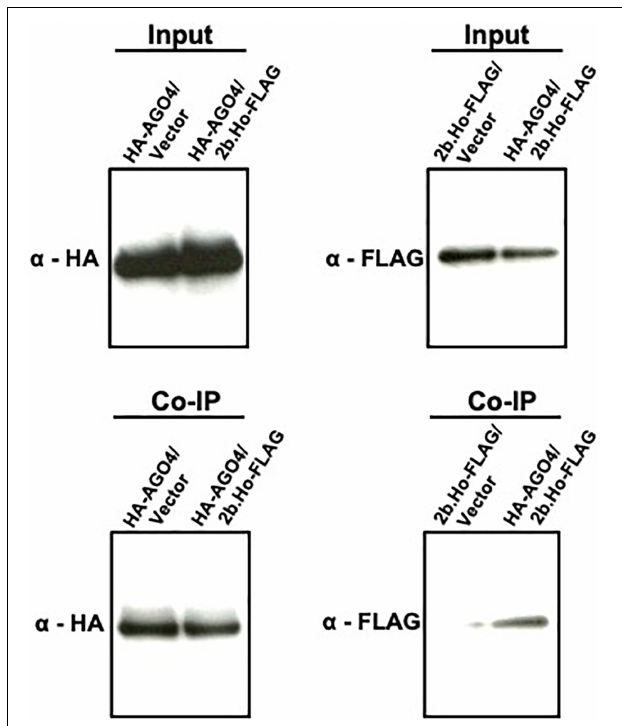
FIGURE 11 | Co-immunoprecipitation (Co-IP) analysis of AGO4 protein with 2b protein of CMV(Ho) employing the transient expression agroinfiltration method in N. benthamiana . Hemagglutinin (HA) epitope sequence-tagged cDNA for AGO4 RNA (p35S:HA-AGO4 in Supplementary Figure 4B ) and FLAG epitope sequence-tagged cDNA for 2b RNA of CMV(Ho) (p35S:2b.Ho-FLAG in Supplementary Figure 4B ) were transiently expressed by the agroinfiltration method in N. benthamiana leaves (HA-AGO4/2b.Ho-FLAG). As a control, HA epitope sequence-tagged cDNA for AGO4 RNA (p35S:HA-AGO4 in Supplementary Figure 4B ) or FLAG epitope sequence-tagged cDNA for 2b RNA of CMV(Ho) (p35S:2b.Ho-FLAG in Supplementary Figure 4B ) was also transiently expressed (HA-AGO4/vector and 2b-FLAG/vector, respectively). HA-tagged AGO4 protein (HA-AGO4) and FLAG-tagged 2b protein (2b-FLAG) in leaf homogenates from agroinfiltrated N. benthamiana leaves, which were used as “input” for Co-IP analysis, were detected immunologically using antibodies against the HA ( α -HA) and FLAG ( α -FLAG) epitopes, respectively. In Co-IP, HA-AGO4 binding to anti-HA agarose beads was detected immunologically by α -HA, and 2b-FLAG, which was co-immunoprecipitated with HA-AGO4, was assessed using α -FLAG.